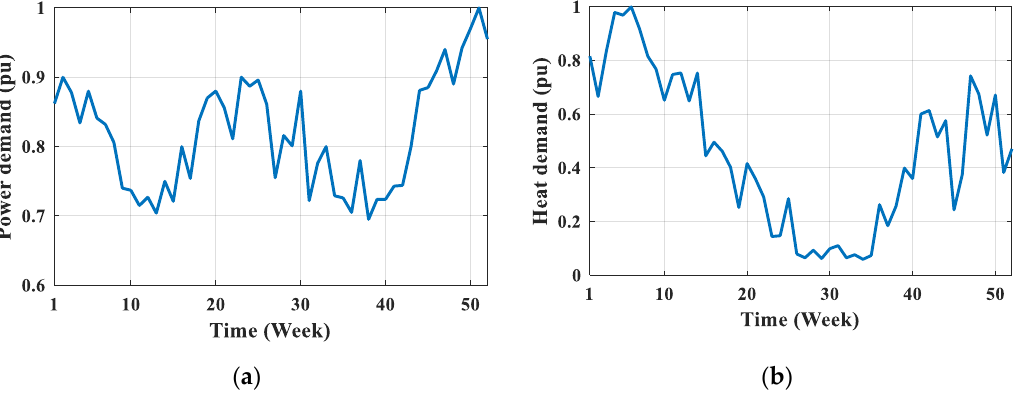
Figure 6. Long-term demands for maintenance scheduling. ( a ) Power demand [50]; ( b ) heat demand